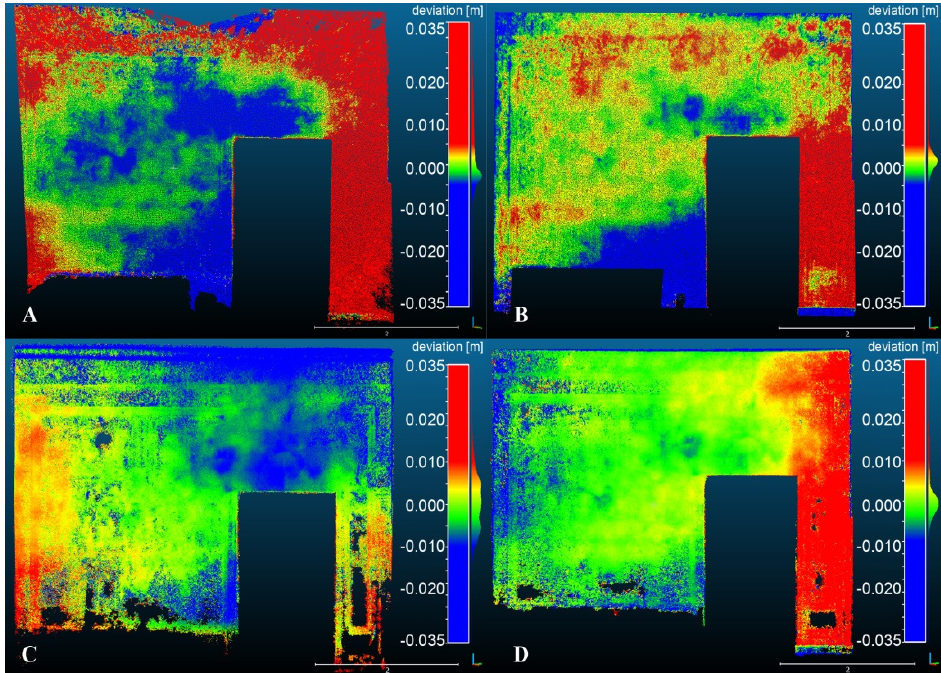
Figure 10. Map of MVS point deviation from a fitted plane a) Xiaomi Yi 2k, b) Xiaomi Yi 4k,